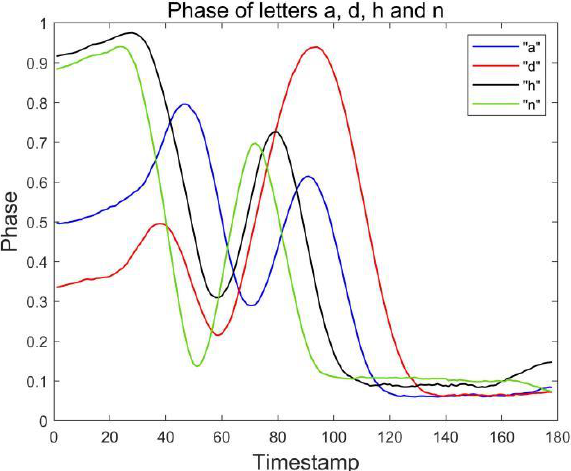
Figure 5. Phases of letters a, d, h and n collected by antenna #2.